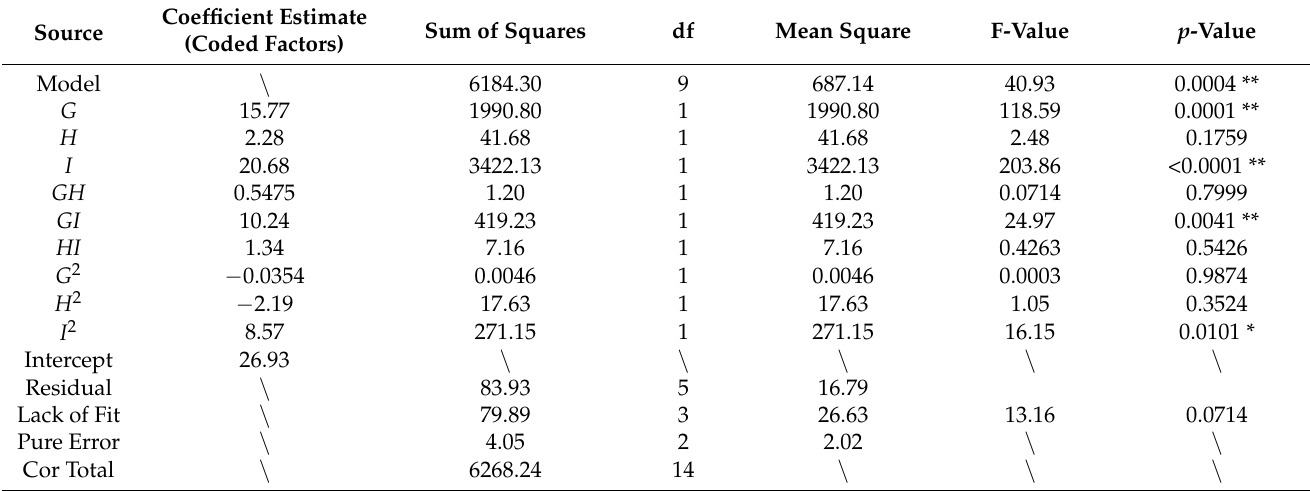
Table 8. ANOVA for bonding parameter Box–Behnken simulation result.